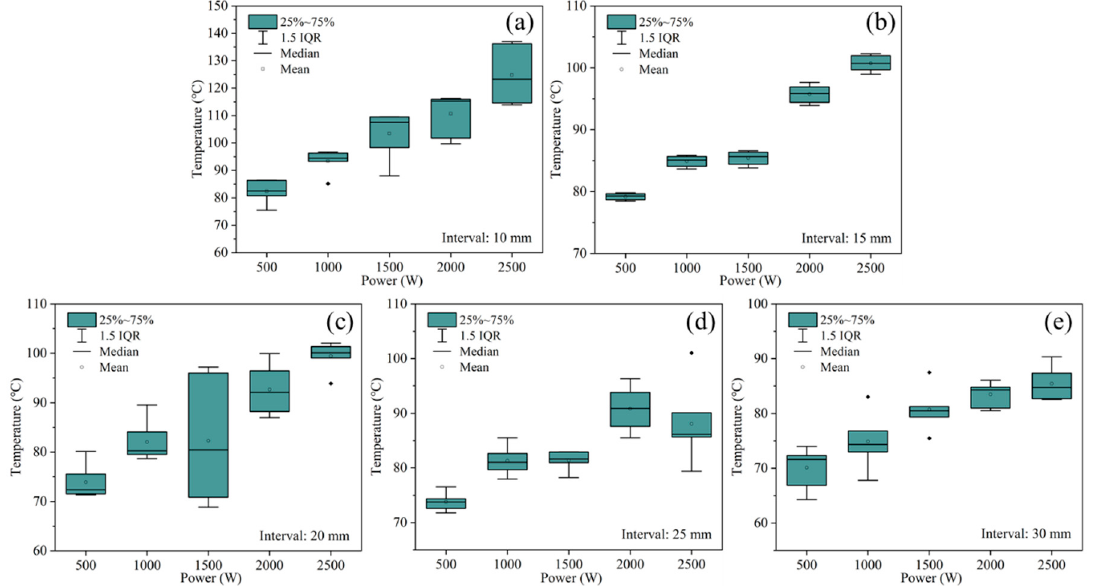
Figure 10. Predicted surface temperatures of servers under different combinations: ( a ) 10 mm, ( b ) 15 mm, ( c ) 20 mm, ( d ) 25 mm, and ( e ) 30 mm.